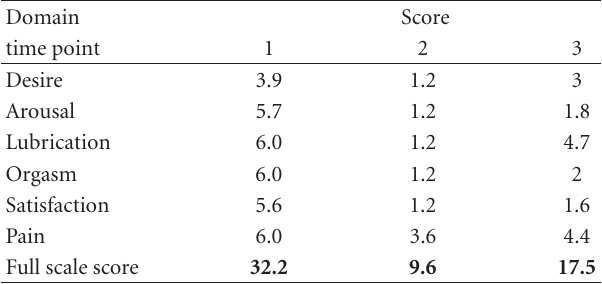
Table 1: Hysterectomy patient